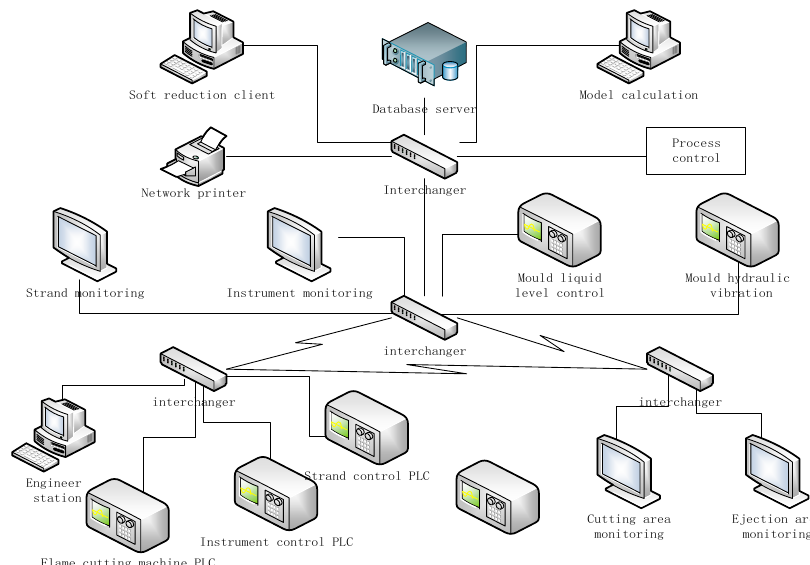
Figure 2. Topological structure of the continuous casting production data acquisition system.